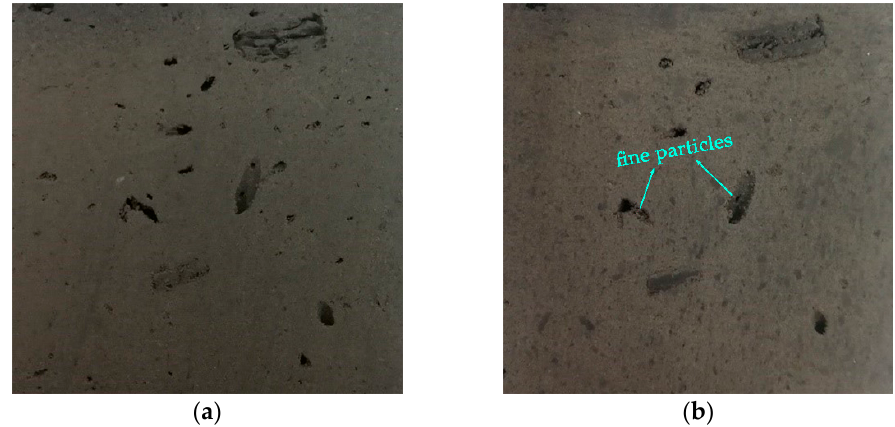
Figure 3. Images of the failure characteristics of gray brick specimens before and after freezing and thawing cycle: ( a ) the 0th freeze–thaw cycle; ( b ) the 55th freeze–thaw cycle.